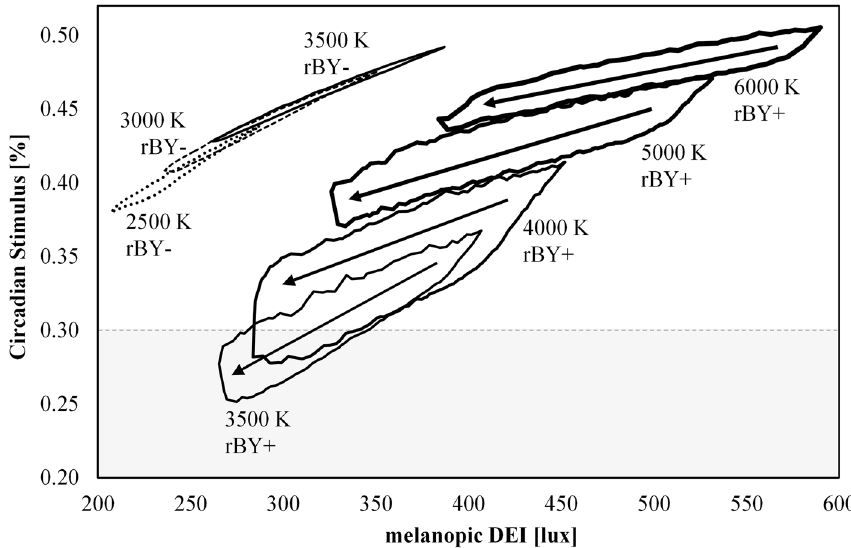
Figure 13. Circadian Stimulus (CS) as a function of melanopic equivalent daylight illuminance (mel-EDI) at a photopic illuminance of 500 lx enlarged from Fig. 12 with the addition of subdivisions for nominal CCT. Arrows show, on average, increasing R f . Zooming in on the relationship at a fixed illuminance illustrates the large range of achievable CS values at a fixed mel-EDI that is driven by spectral configuration and partly driven by the discontinuity between “blue wins” (rBY+) and “yellow wins” (rBY-) of the CS model. The horizontal grey dashed line indicates the daytime CS recommendation of CS ≥ 0.3 of UL 24480.